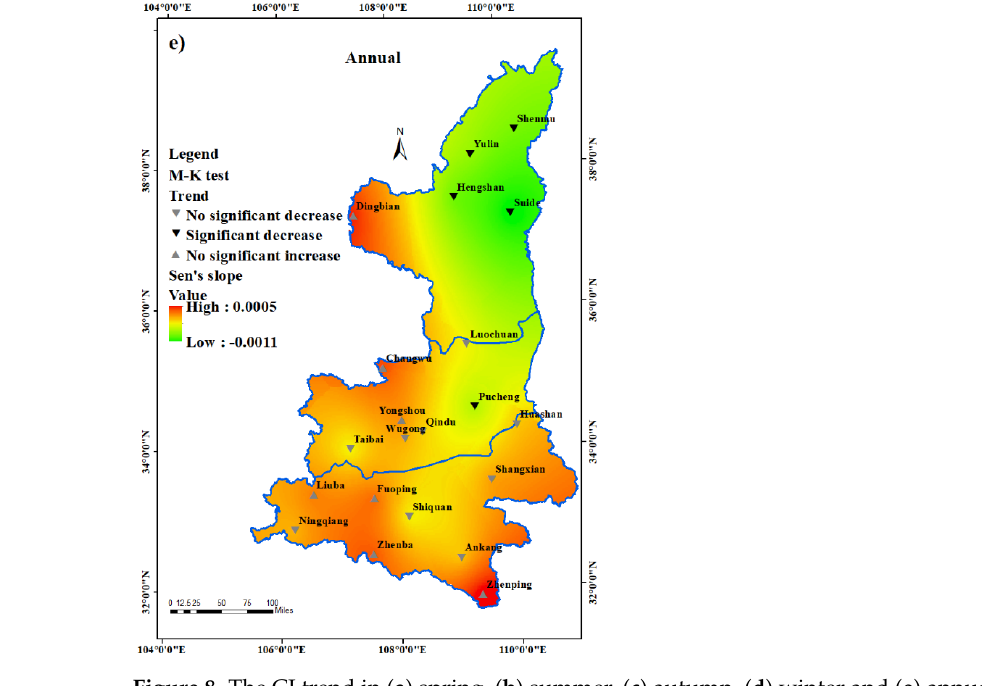
Figure 8. The CI trend in ( a ) spring, ( b ) summer, ( c ) autumn, ( d ) winter and ( e ) annually in Shanxi Province. Table 5. Z value of